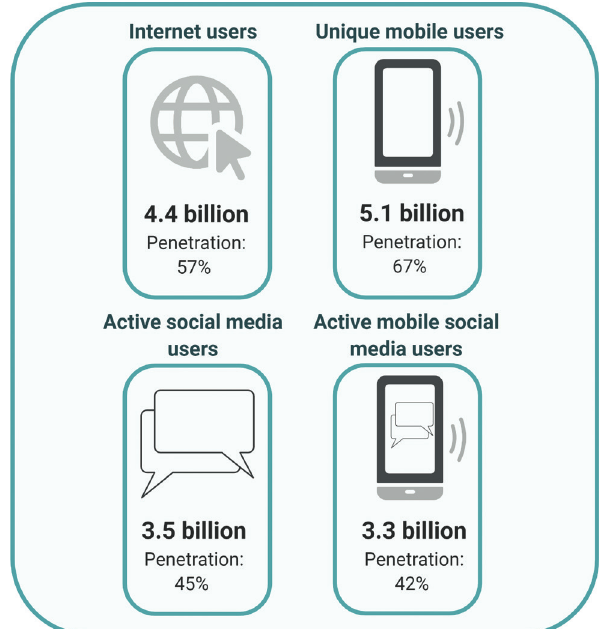
Key statistical indicators for global big data use. The number of users and portion of the population that has access (penetration) to the Internet, mobile phones, social media and mobile social media. Data were accessed via the Global Digital Report 2019